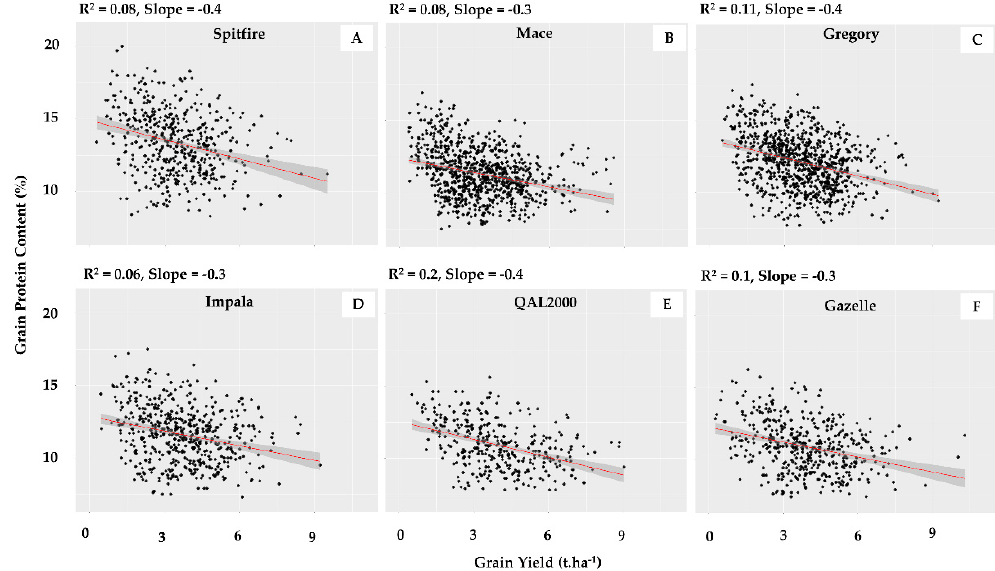
Figure 5. Relationship between grain yield and grain protein content of six selected wheat varieties obtained from NVT sites across Australia between 2008 and 2018. The number of available data for each variety was 476 (Spitfire), 850 (Mace), 897 (Gregory), 522 (Impala), 346 (QAL2000), and 445 (Gazelle). R 2 represents the correlation coefficient, and slope refers to the slope of the regression line. The negative relationship in all figures is significant.